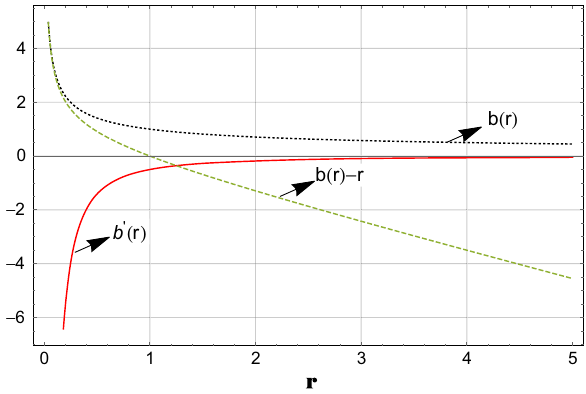
Fig. 1 Behaviour of the shape function b ( r ) with r 0 = 1 and m = 0 .